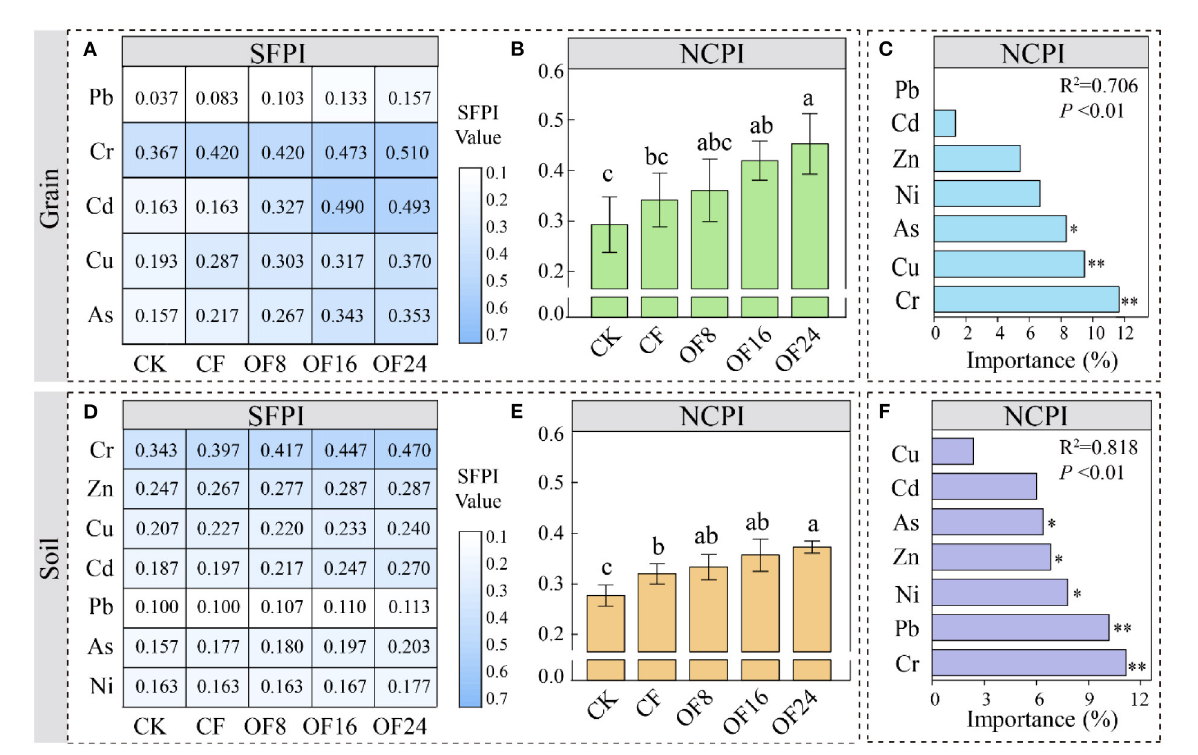
FIGURE5 Risk assessment of heavy metal pollution in maize grain (A,B) and soil (D,E) using the single factor pollution index (SFPI, A,D ) and Nemerow comprehensive pollution index (NCPI, B,E ) methods. Random forest analysis predicts the key factors affecting NCPI in maize grain (C) and soil (F) . In panels (A,D) , the degree of shades of blue is positively correlated with the SFPI value of each indicator ( n = 3). The error bars show the standard deviation of the mean of each treatment ( n = 3). Different lowercase letters represent significant differences at the level of p < 0.05. * and ** represent significant differences at the level of p < 0.05 and p < 0.01,